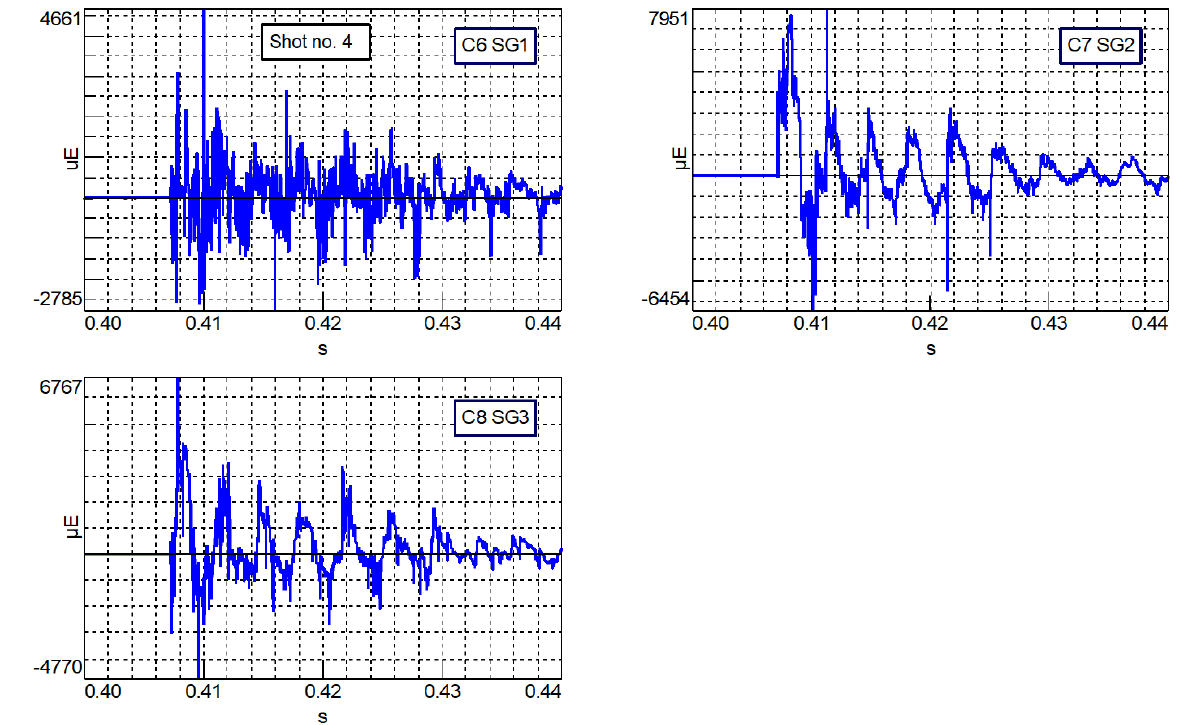
Figure 16. Strains recorded by 3 tensiometers (shot no. 4).